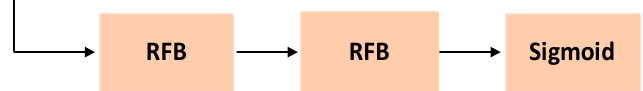
   Figure 4. Structure of Receptive Field Block. 2.2.2. RFB Stacked Segmentation Network Branch We replaced each convolution layer of the original segmentation branch of Mask R ‐ CNN with the RFB module, and then activated with sigmoid function, as shown in Figure 5. Two RFB modules